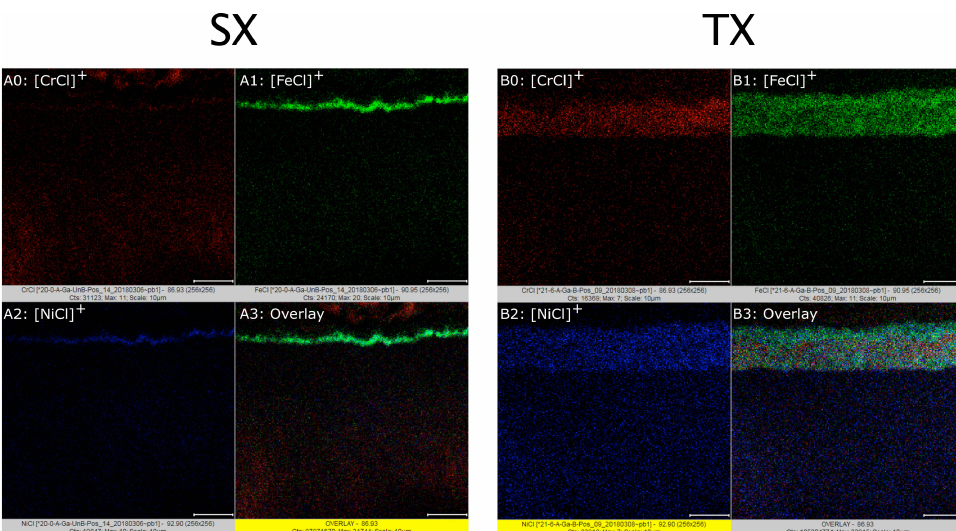
Figure 9. ToF-SIMS maps [CrCl] + , [FeCl] + , [NiCl] + and overlay. SX : activated by direct HCl gas exposure with the “double-HCl” process. TX : activated by gas from pyrolysis of 15 N 2 H 4 Cl.